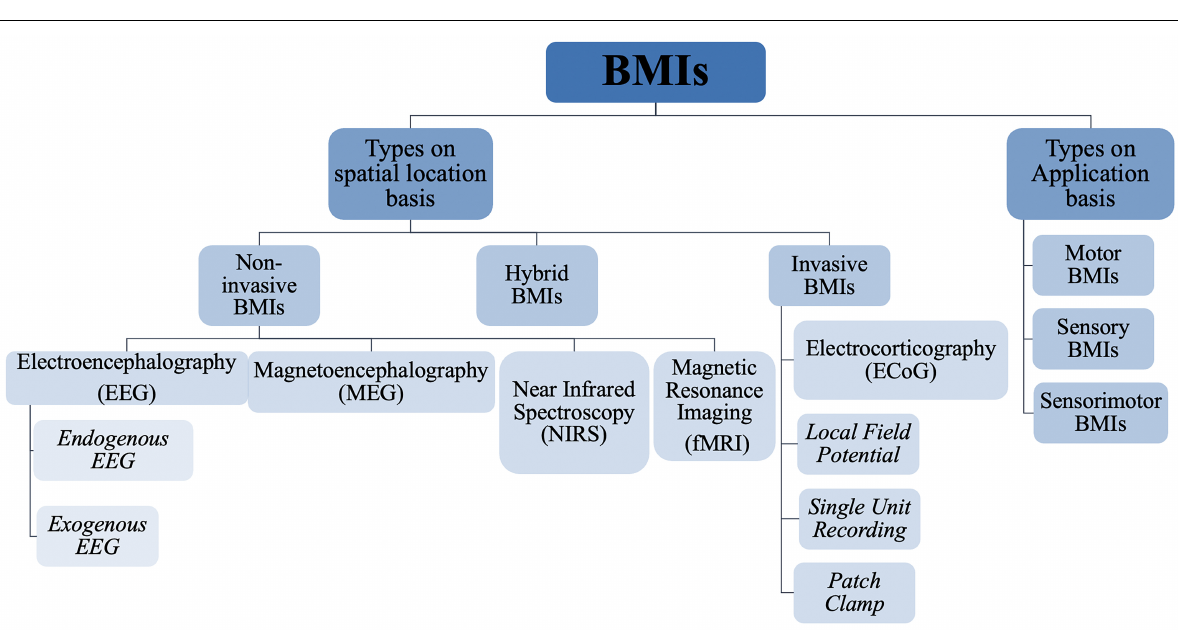
FIGURE 7 | Hierarchical classification of brain machine interfaces based on their spatial position and